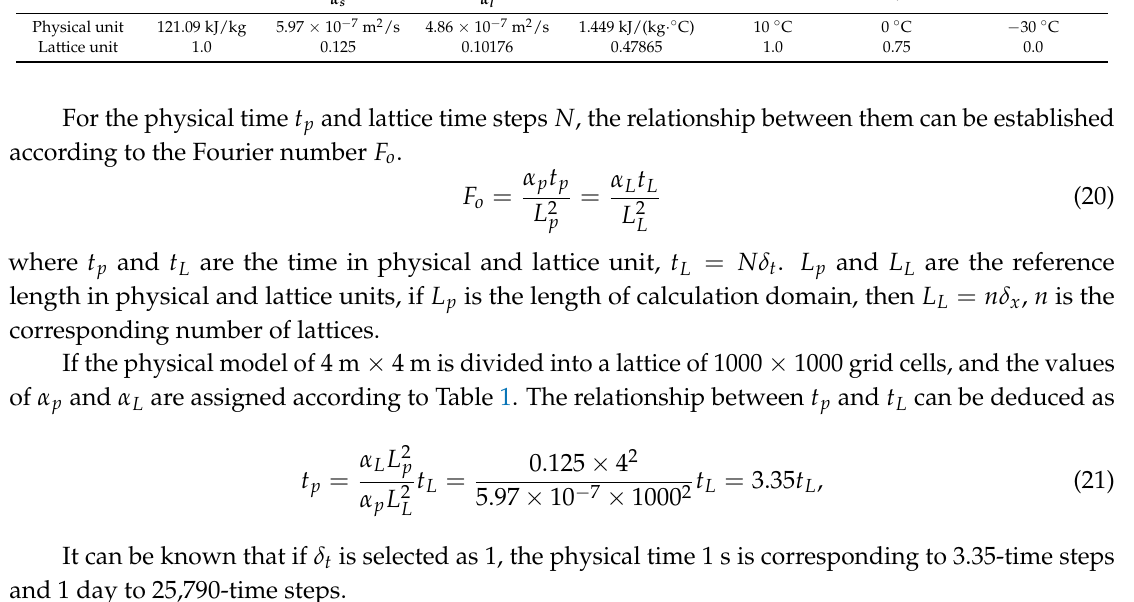
Figure 3. Diagram of heat conduction problem with phase change in semi-infinite space . To verify accuracy of proposed model, LBM is applied to simulate the heat conduction problem with solid–liquid phase change in semi-infinite space, as shown in Figure 3. At the time